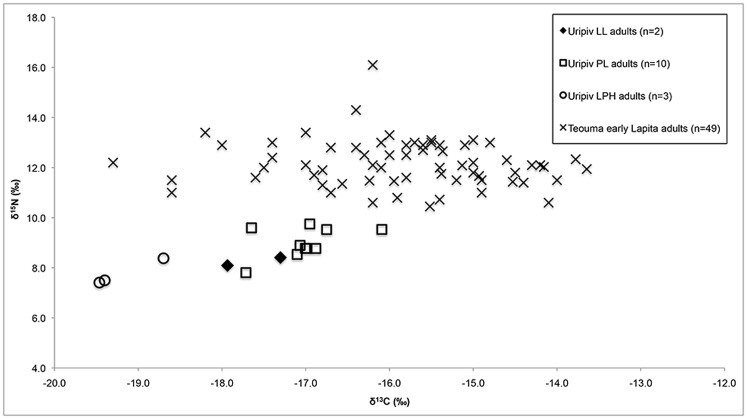
Comparison of bone collagen δ13C and δ15N values of Uripiv and Teouma adult humans.